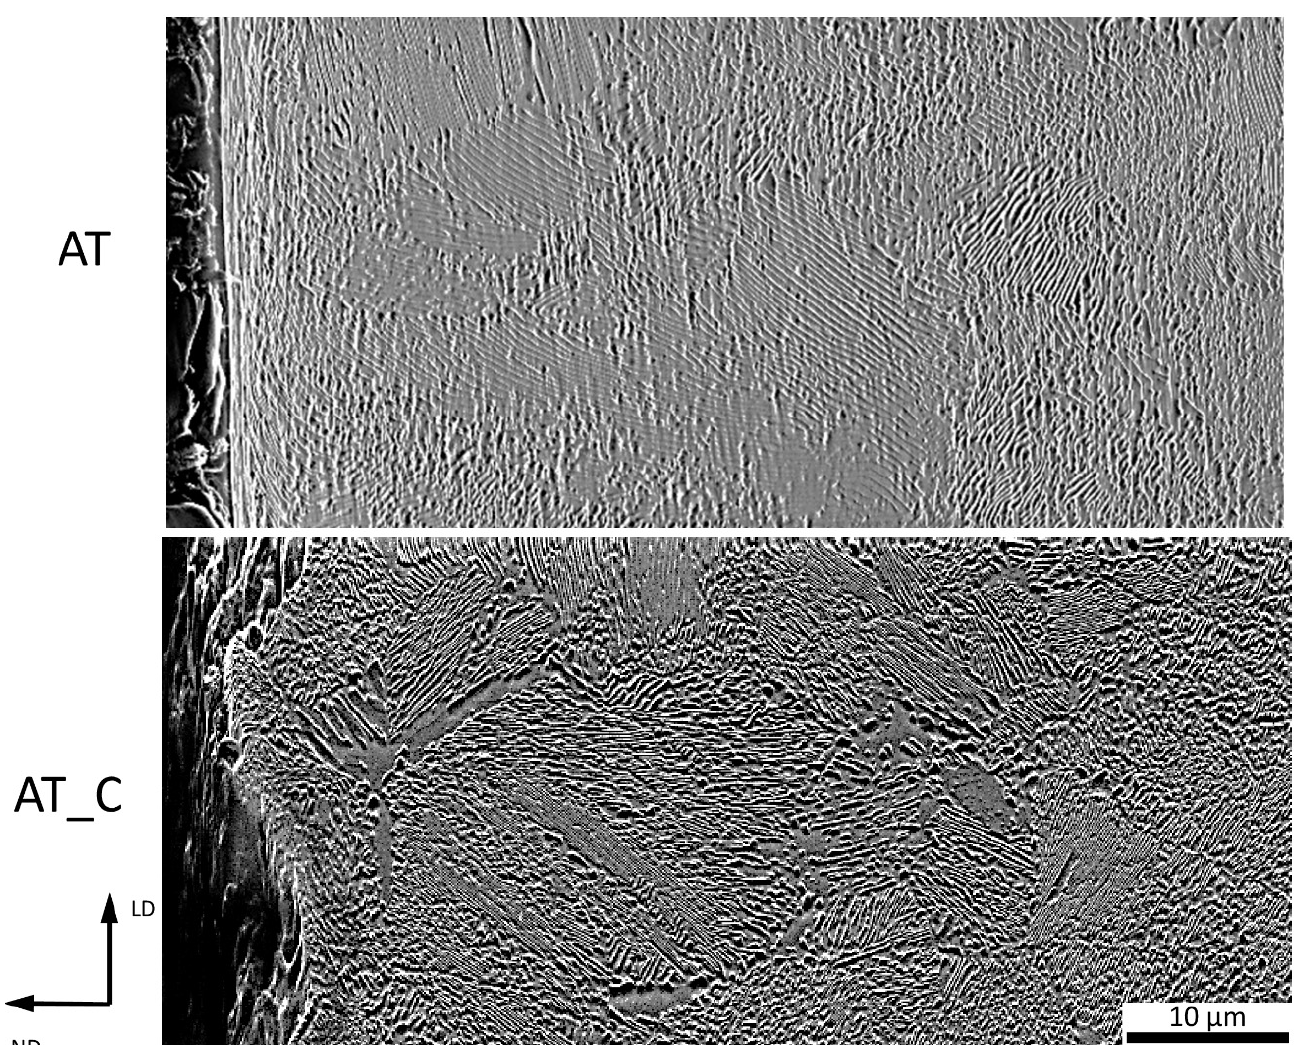
Figure A2. SEM images for the non-deformed state (T0) for Ring AT and Ring AT_C. The measure- ments were performed along the longitudinal direction.